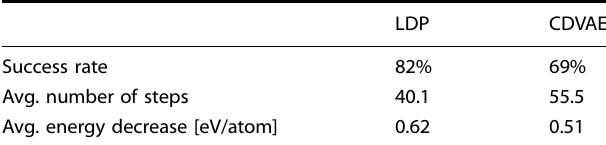
Fig. 2 Work fl ow diagram. Work fl ow to generate candidate 2D materials using the CDVAE generative model (left branch) and lattice decoration (right branch). The same set of 2615 materials is used to train the CDVAE model and as seed structures for lattice decoration, respectively. Black numbers indicate the number of materials present at a given step of the work fl ow while orange numbers indicate number of materials discarded. Table 1. Summary statistics for the DFT relaxation of the two methods for generating initial